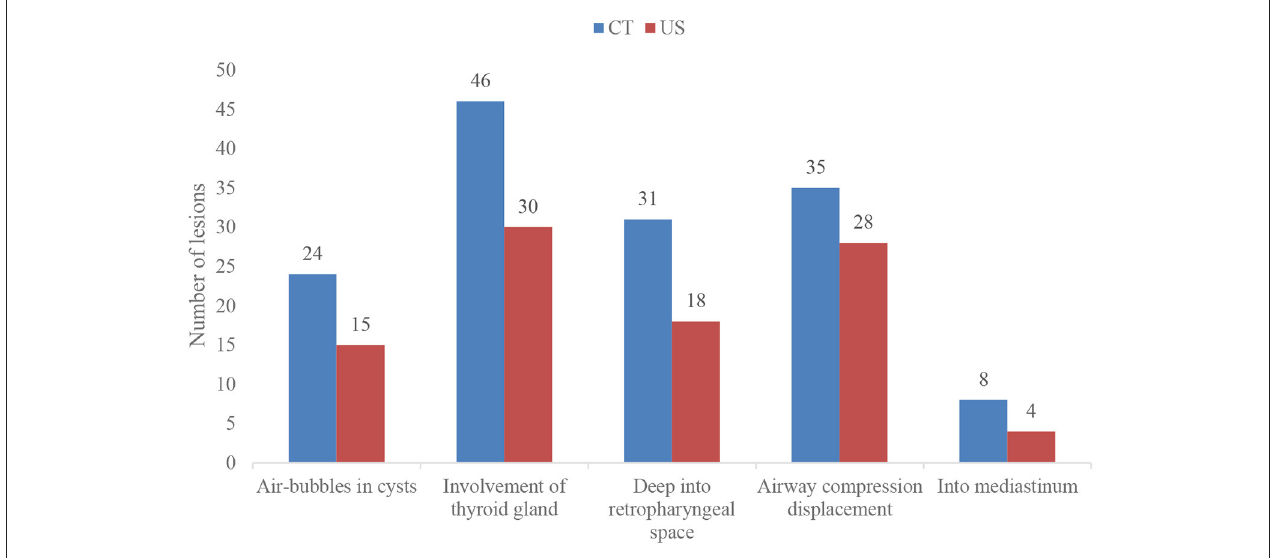
FIGURE 5 | Comparison of CT and US imaging findings of CPSF.